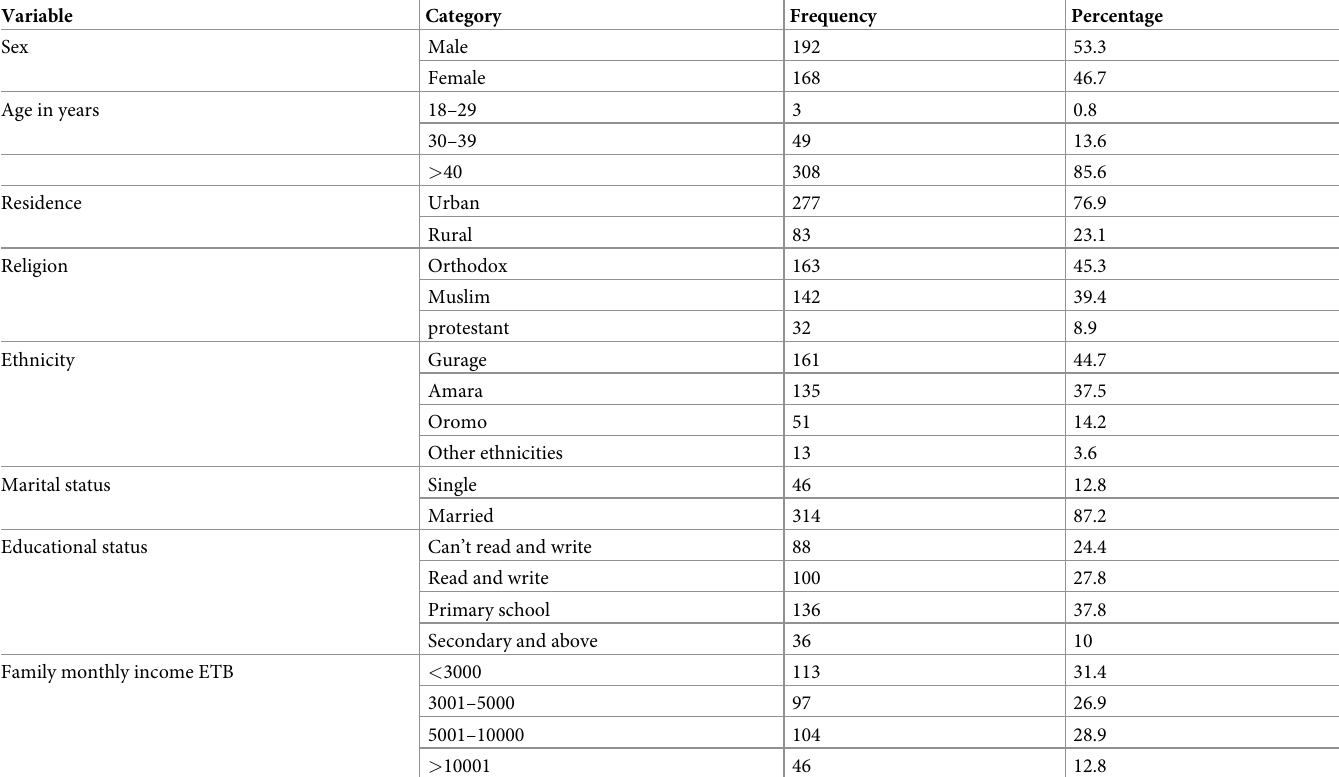
Table 1. Socio-demographic characteristics of study participants in Gurage zone 2021 (n =